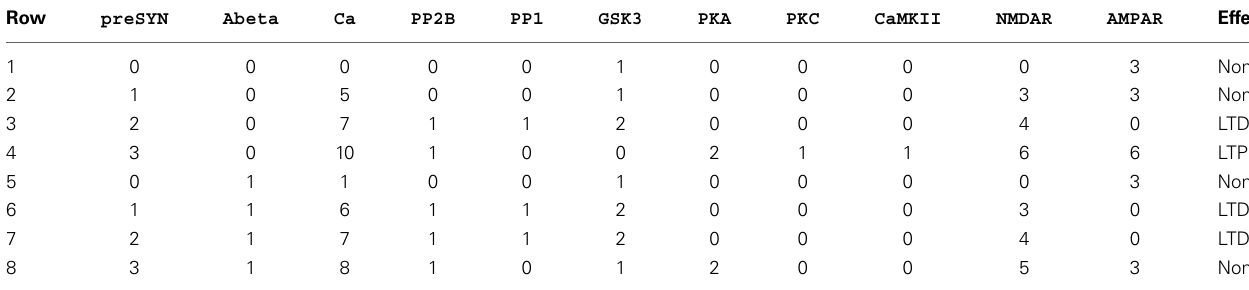
Table 2 | Model element levels at different levels of presynaptic activity. Row preSYN